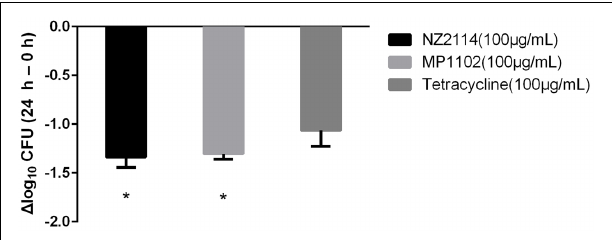
FIGURE 3 | The bactericidal activities of antimicrobials against strain S. aureus E48 in mammary epithelial cells. The Y -axis shows the change in Log 10 CFU/well after 24 h of incubation compared with the initial number of intracellular bacteria. Each value represents the mean ± SD. An asterisk ( ∗ ) demonstrates a significant difference ( P < 0.05) versus the tetracycline group.